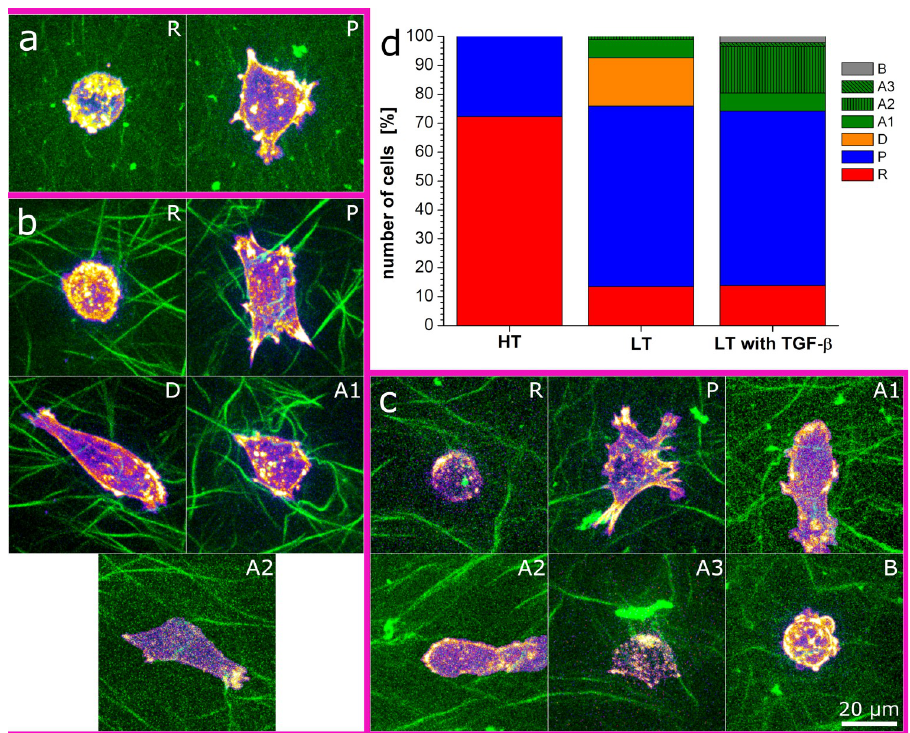
Fig 3. Migratory phenotypes of MDA-MB-231 cells in collagen gels. a) round (R) and pseudopodial (P) phenotype in HT gels; b) round (R), pseudopodial (P), adherent (D), amoeboid, including ellipsoid with leading edge (A1) and squeeze (A2) phenotype in LT gels, c) round (R), pseudopodial (P), amoeboid including ellipsoid with leading edge (A1), squeezing (A2), and rear driven (A3), and blebbing (B) phenotype in LT gels upon addition of TGF- β ; collagen fibers are displayed in green and cellular actin is shown in purple (low concentration) and yellow (high concentration) d) phenotype distribution within the different gel types showing the high amount of round cells in HT gels, the adherent cells specifically occurring in LT gels and the increase in amoeboid cells in LT gels upon addition of TGF- β .